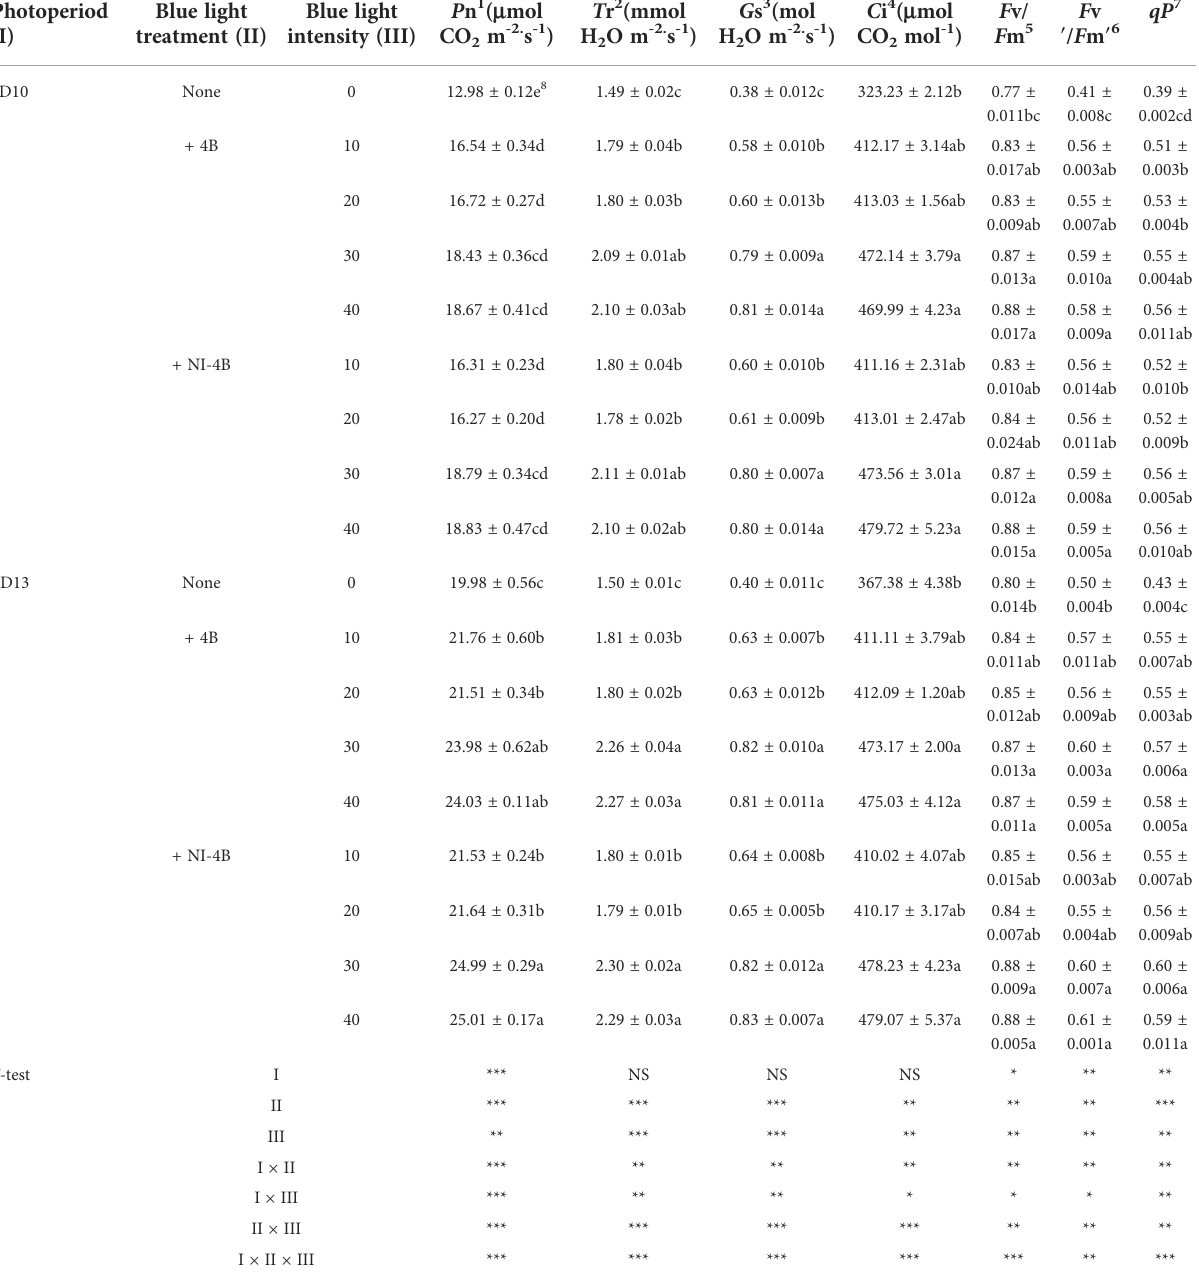
TABLE 2 The photosynthetic and chlorophyll fl uorescence characteristics of chrysanthemum ‘ Gaya Glory ’ under different intensities of supplemental or night-interruptional blue light, after 60 days of exposure to the photoperiodic light treatments.